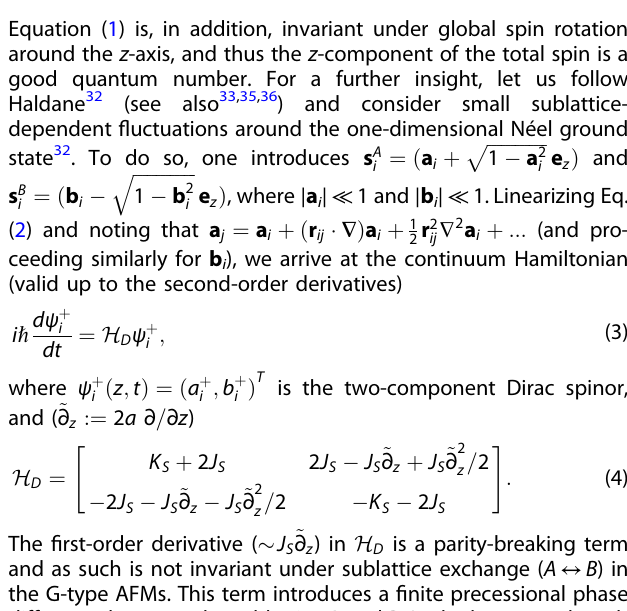
Fig. 1 Schematic representation of twisted magnon beams in AFM waveguide. a Twisted magnon beams propagating along a cylindrical AFM waveguide with two magnetic sublattices A (up arrows) and B (down arrows). b Degenerate right- and left-handed spin wave modes, L j i and R j i dominated by the sublattice A and B, respectively. The small magnetization (green arrows) is de fi ned as m ¼ ð S A þ S B Þ = 2 S Þ